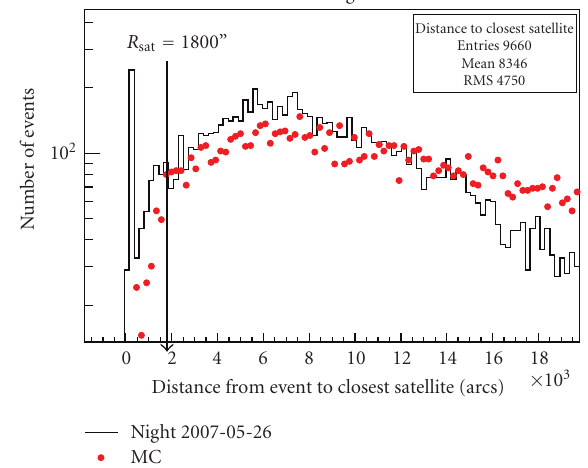
Figure 4: Distribution of the distance from flash event candidate to the closest satellite from the catalogue, for events found by coincidence algorithm during night 2004.10.28/29. For comparison distances from randomly generated flashes to the nearest satel- lite are shown as red dots—combinatorial background is nicely reproduced. For the purpose of this analysis signal threshold was decreased to have more accidental coincidences.